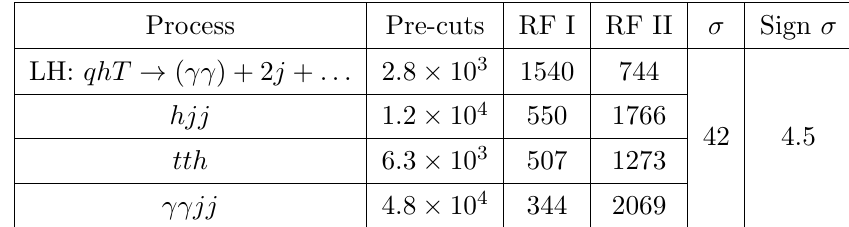
Table 5 . First three columns: signal and background event numbers in the (cid:13)(cid:13) + 2 j + X channel in the LH benchmark model, in a 30 ab (cid:0) 1 sample at a 100 TeV pp collider. Fourth column: Poisson signi(cid:12)cance [42] for discriminating signal+background model from pure background. Fifth column: Poisson signi(cid:12)cance for discriminating signal+background models with \correct" and \wrong" signs of Y TTh